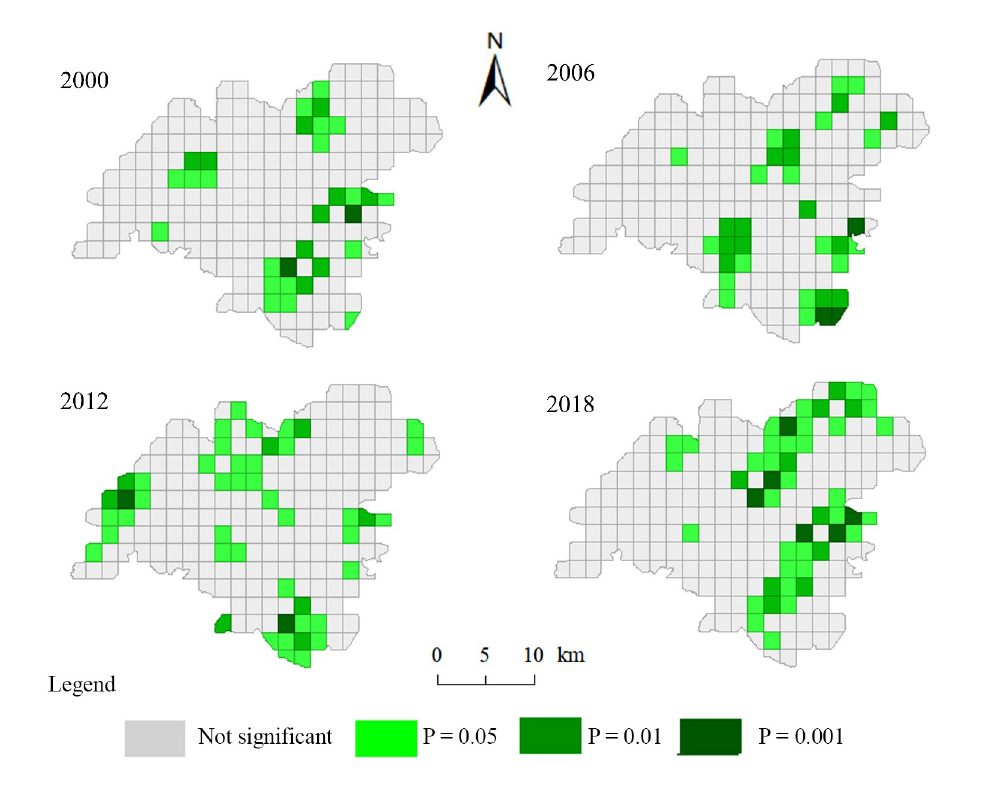
Figure 6. LISA significance level of local spatial autocorrelation of landscape ecological security in Zhong County in the study